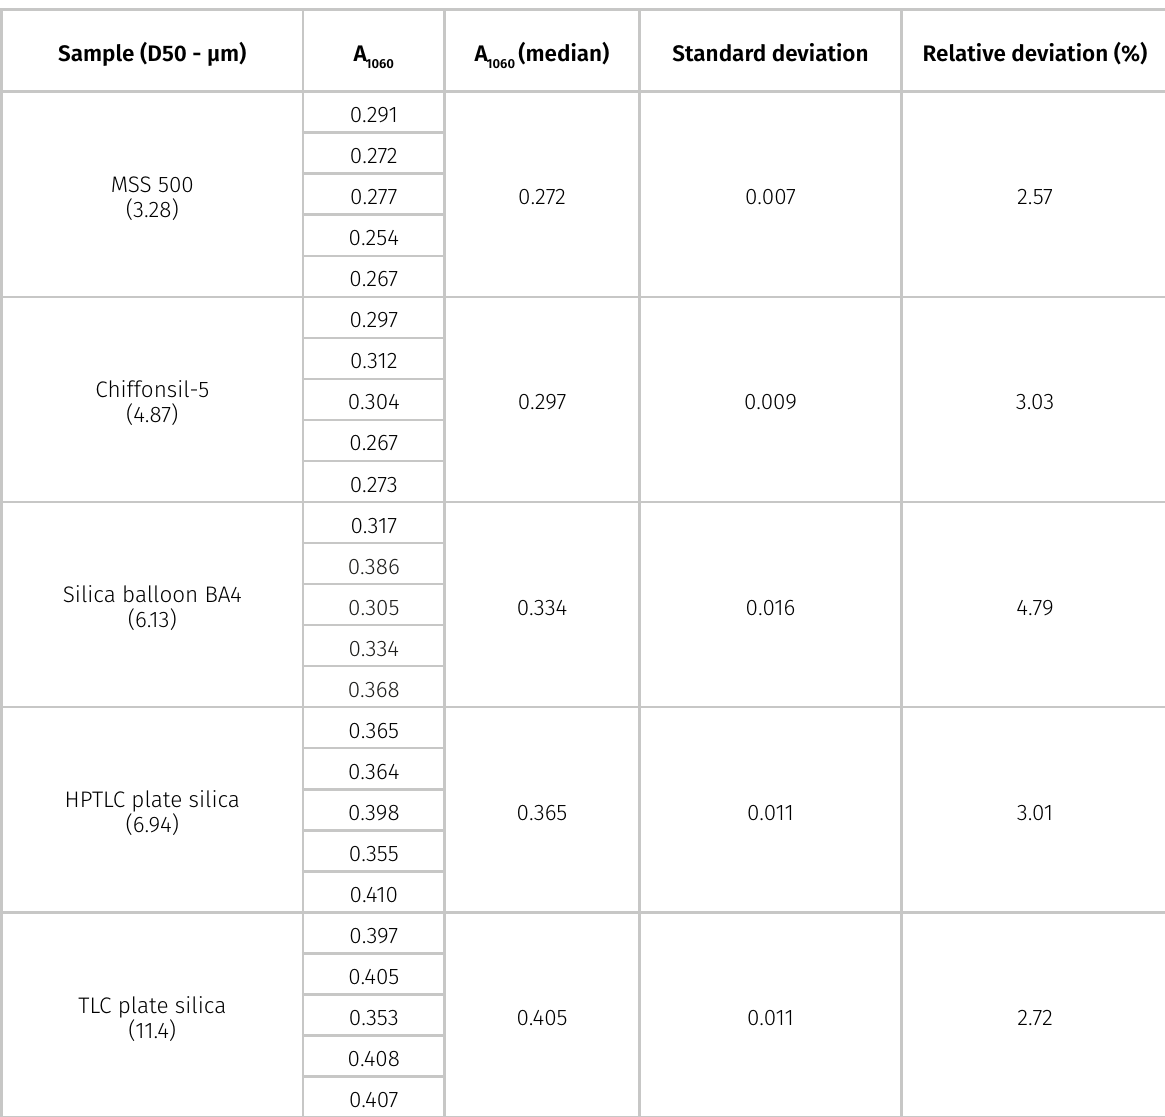
Table V. Data from the DRIFT / MIR methodology (A Fraunhofer